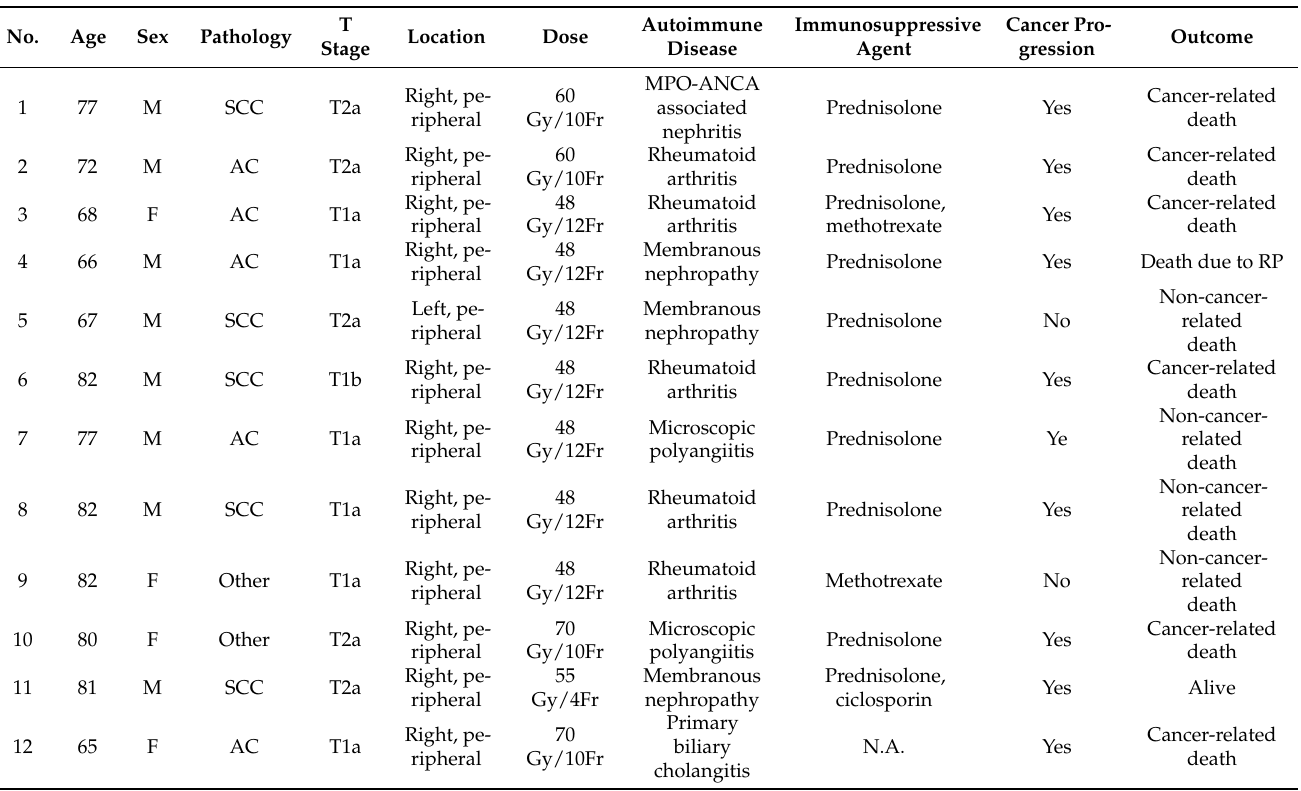
Table 2. Detailed information for patients with systemic autoimmune